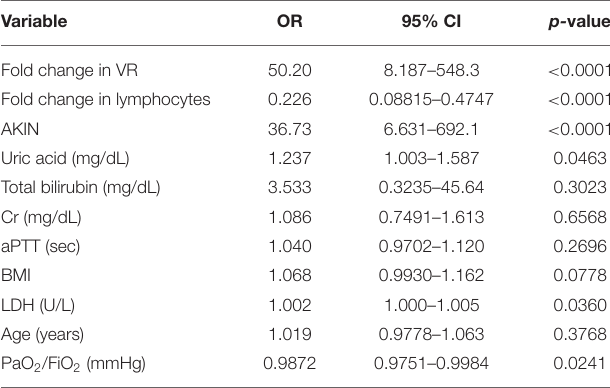
TABLE 4 | Logistic regression analysis of risk factors for COVID-19-associated mortality.